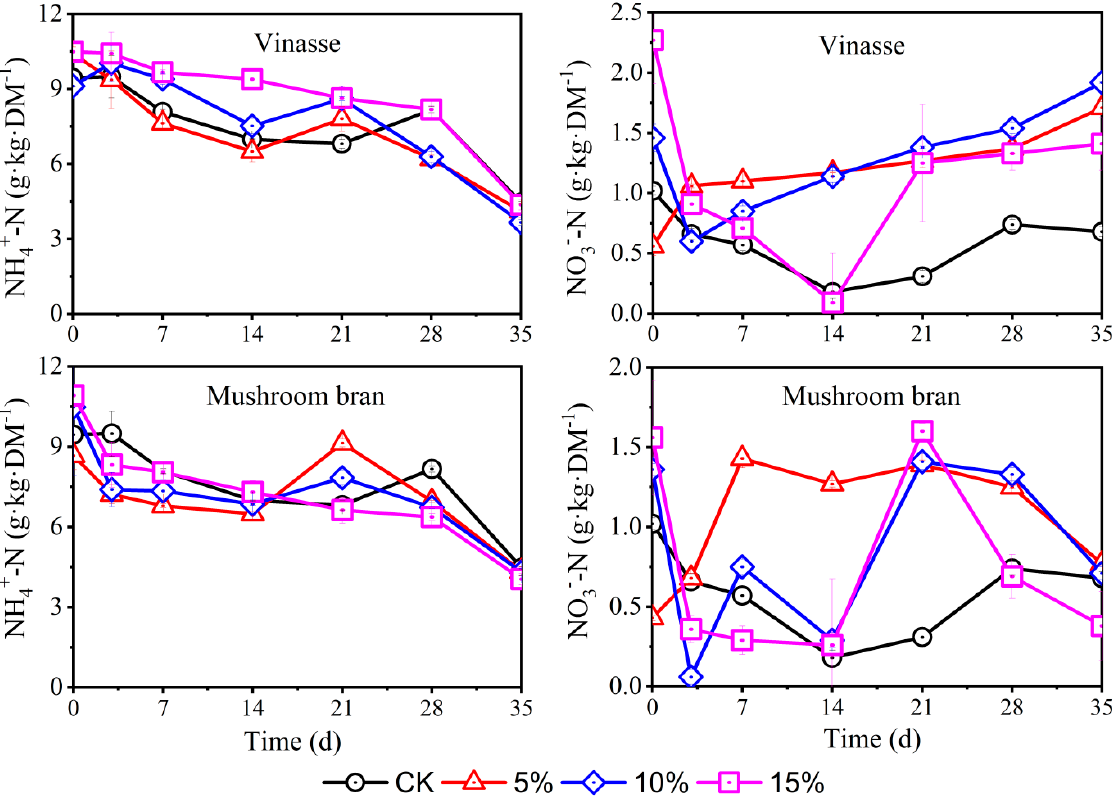
Figure 3. The variation of the NH 4+ -N and NO 3 − -N concentration during composting.